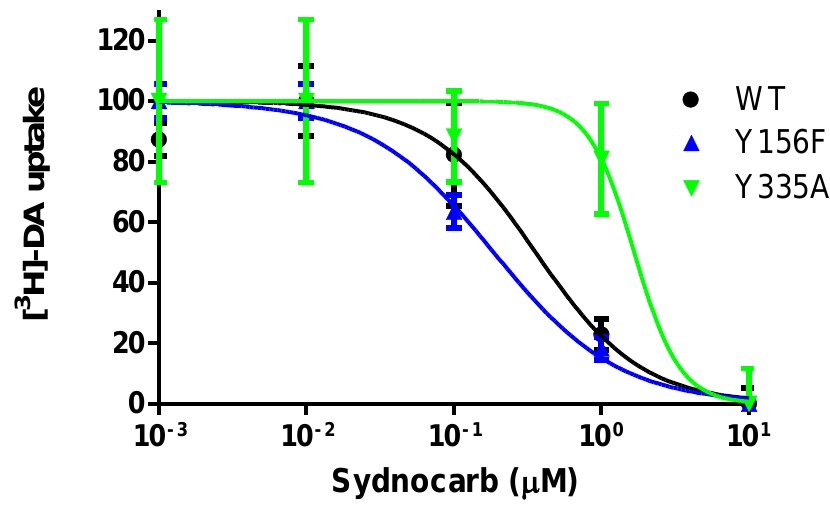
Figure 6. Dose-response assay of sydnocarb against DAT mutants Y156F and Y335A versus WT-DAT. Nonlinear regression analysis of the normalized response gave sydnocarb IC 50 as 0.439 ± 0.135, 0.262 ± 0.118, and 1.419 ± 0.201 µM in WT-DAT, Y156F-DAT, and Y335A-DAT-transfected COS-7 cells, respectively. Averages and SEM were calculated from three independent experiments.